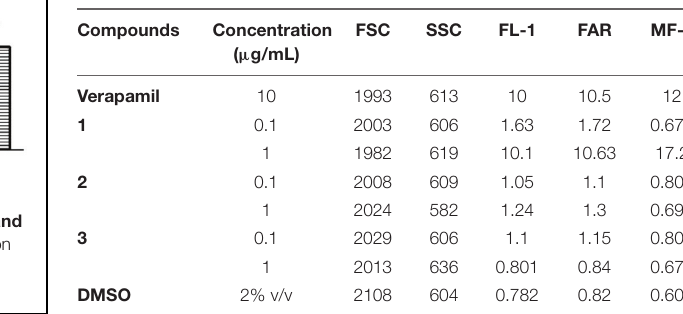
TABLE 6 | Effects of compounds 1–3 on the reversal of multidrug resistance in mouse lymphoma cells in the presence of low doses (0.1–1 μ